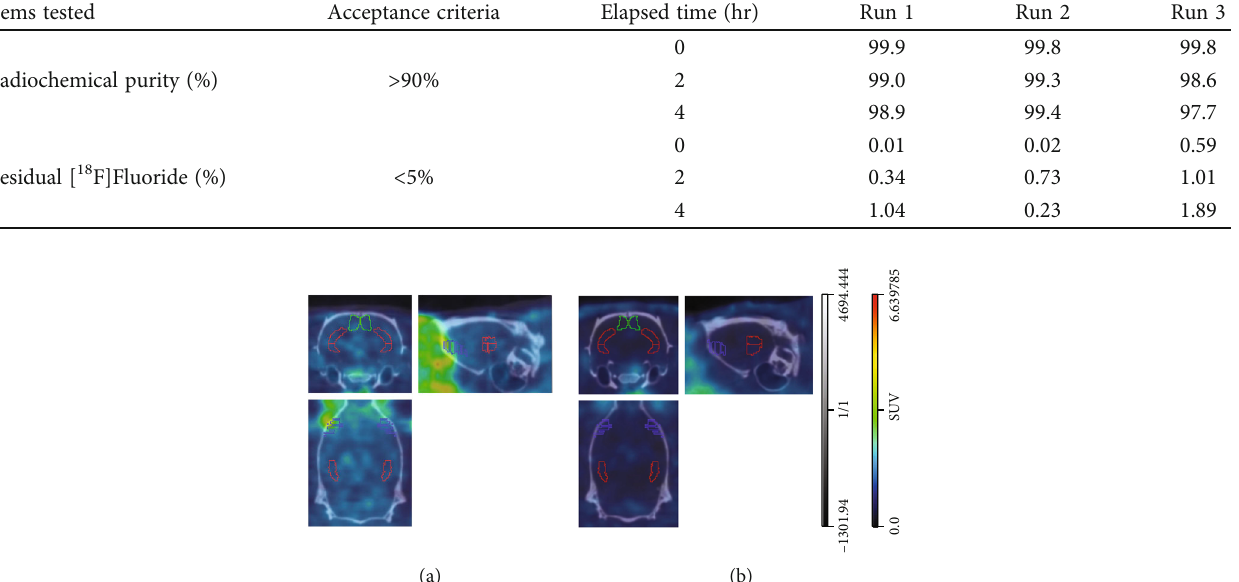
Table 2: Stability of three consecutive productions of the [ 18 F]FEPPA (2) ( n = 3 ).